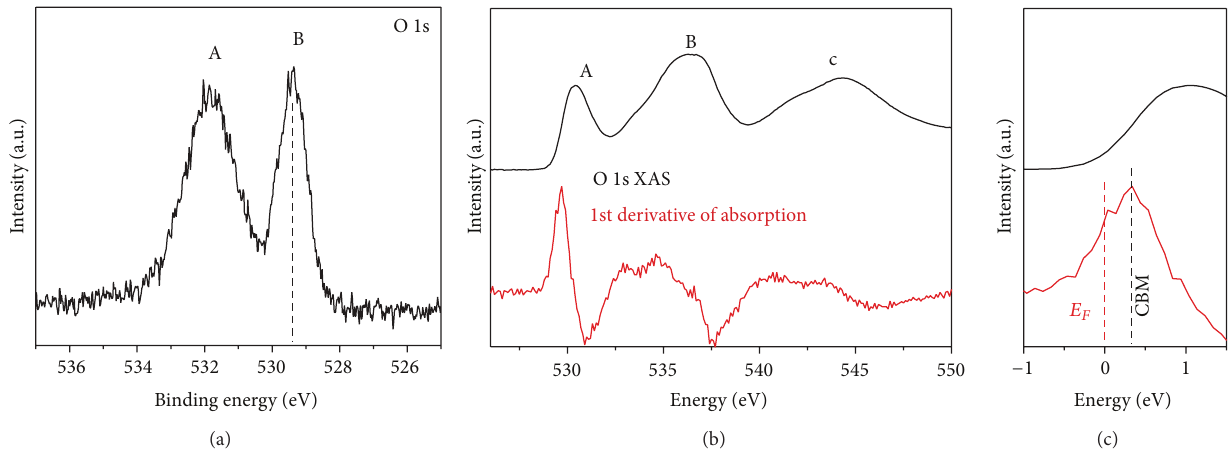
Figure 5: (a) O 1s core electron, (b) O 1s XAS and first derivative of absorption of LSMO thin film, and (c) expanded data (calibrated by O 1s binding energy) in the vicinity of the Fermi level.